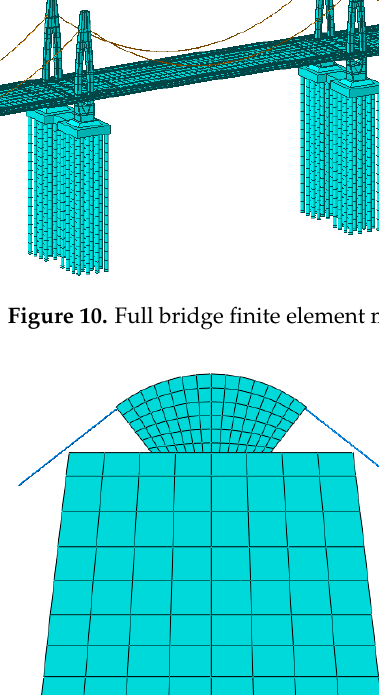
Figure 11. Partial details of main cable and